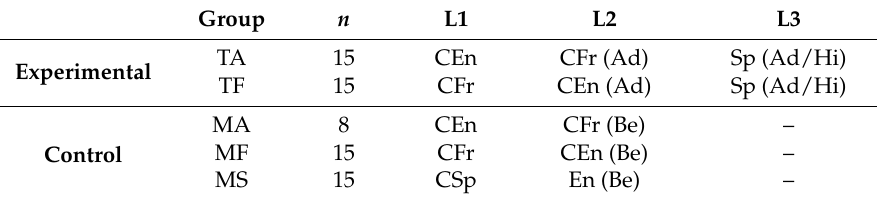
Table 1. Control and experimental groups’ linguistic